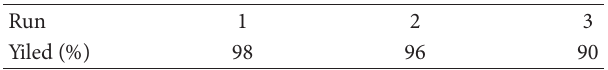
T 5: e recycling experiment ASA in Pechmann